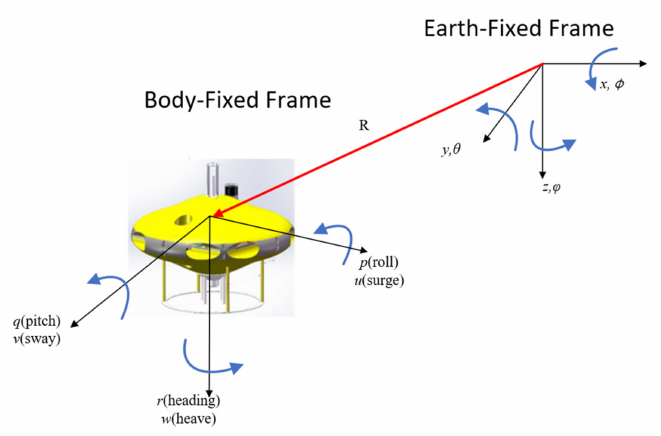
Figure 5. Coordinate system of